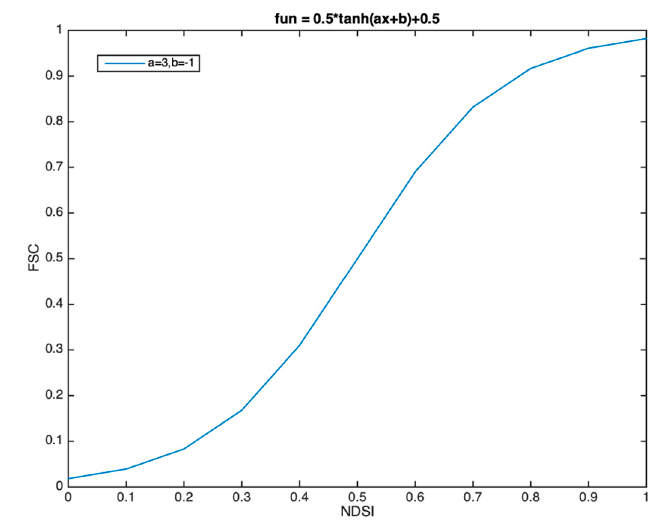
Figure 4. Shape of the function used to estimate the FSC from NDSI.